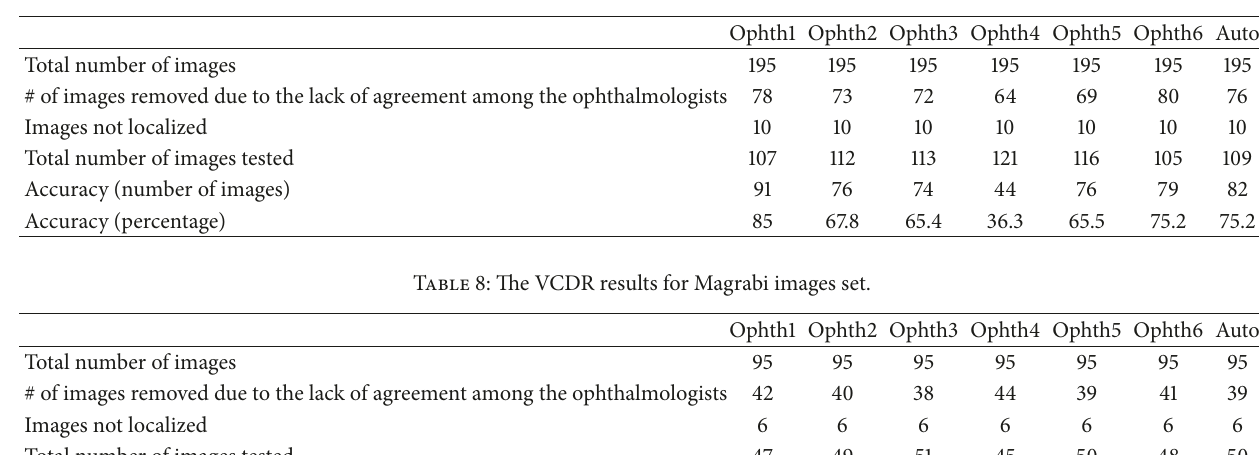
Table 7: The VCDR results for Bin Rushed images set.